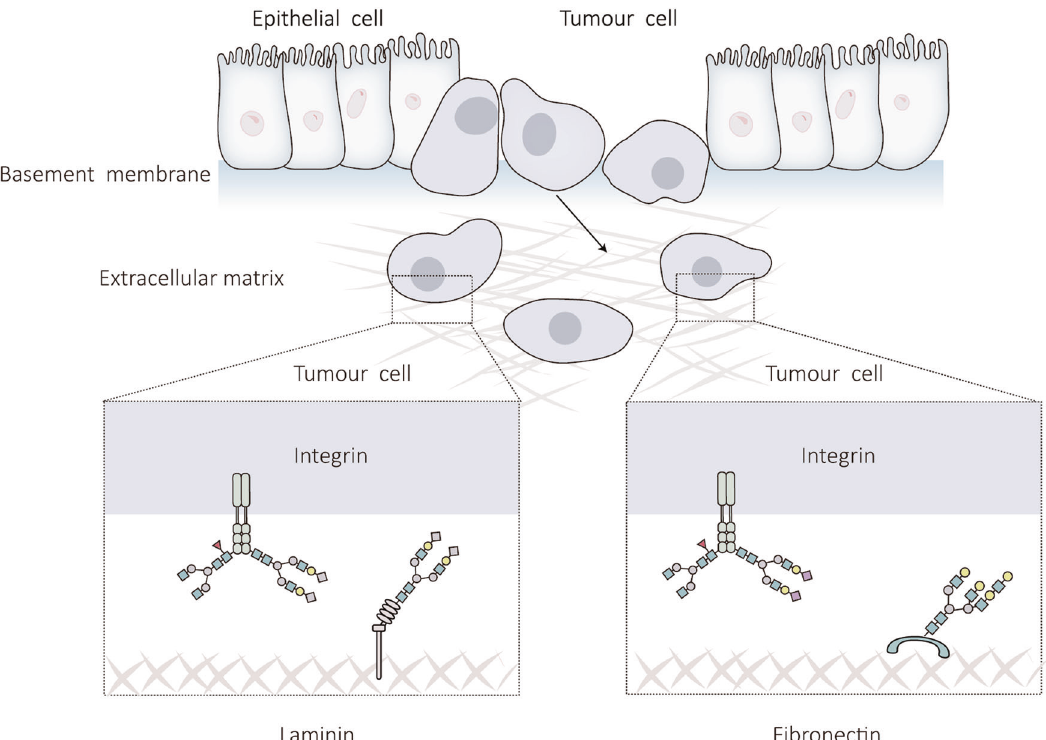
Fig. 4 Effect of N-glycosylation on the ECM. Under normal physiological conditions, the components of the ECM can provide a suitable mechanical environment for cells. However, in liver cancer, the ECM is disordered, which is closely related to the N-glycosylation of ECM components. This fi gure outlines the effect of N-glycosylation on ECM homeostasis in liver